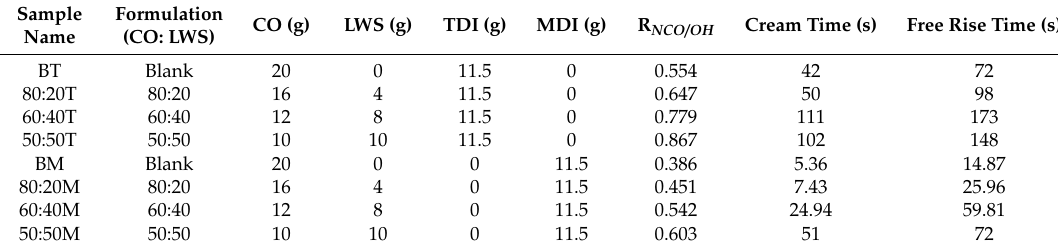
Table 1. Foam formulations and